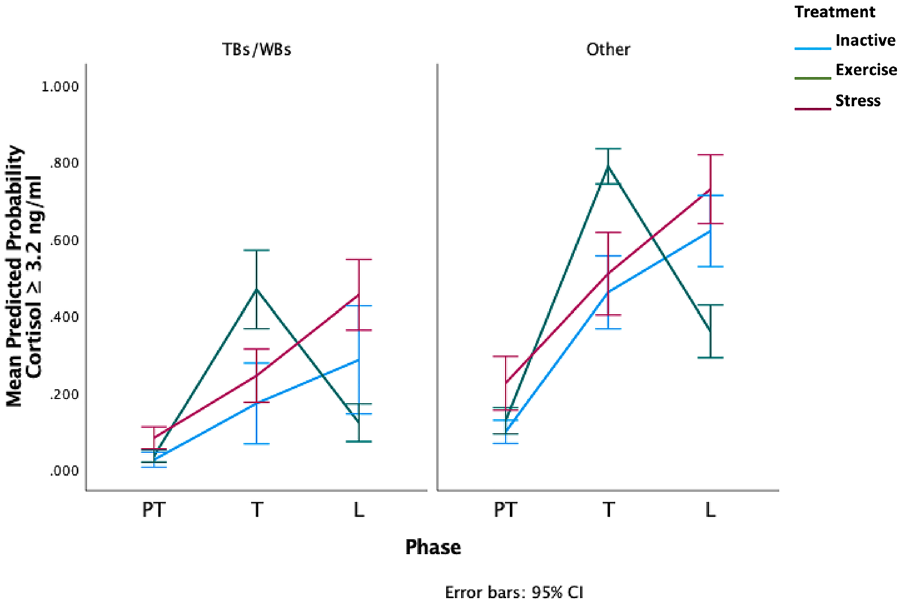
Figure 5. Predicted probability of high salivary cortisol (≥ 3.2 ng/ml) across the three phases. Values of < 0.5 have a lower probability of cortisol concentrations of 3.2 ng/ml or higher and values of 0.5 or greater have a higher probability of cortisol concentrations of 3.2 ng/ml or higher. TBs/WBs = Thoroughbred and warmblood breed horses, Other = Other breeds including Arab, Arab crosses, ponies, crossbreds. (Breed details can be found in Supplementary Table